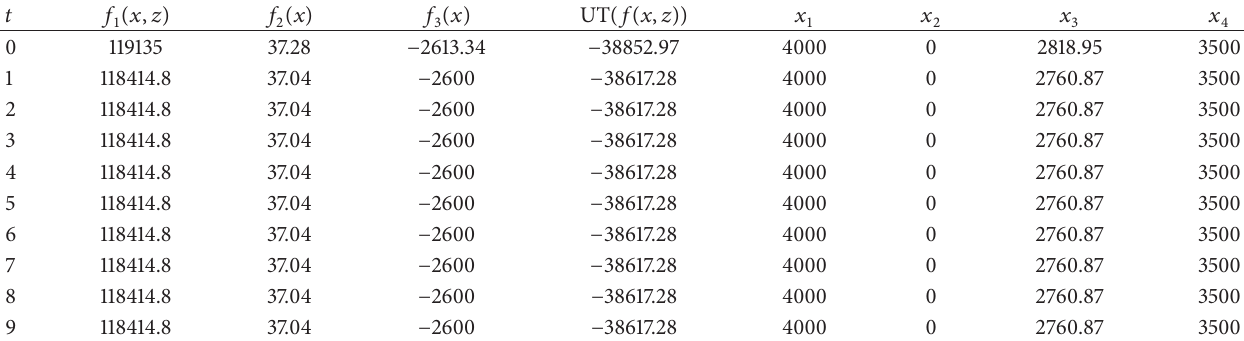
Table 4: The solutions of the subproblems according to the values of 𝑡 at the second iteration.